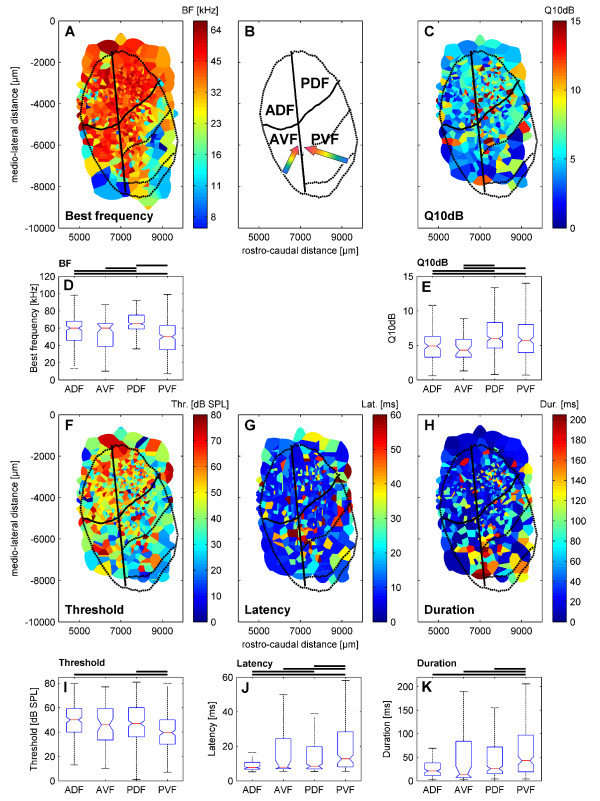
Spatial representation of response properties on the flattened cortical surface and statistical comparison between the four cortical fields. Tessellation maps of the spatial representation are shown for: A) Best frequency, C) Q10dB value, F) Response threshold, G) First spike latency and H) Response duration. The outlines of AC and AC subfields are superimposed (black lines as in Fig 1). Panel B) shows the topographic position of the AC subfields of P. discolor derived from neuroarchitectural characteristics. The arrows indicate BF gradients in the tonotopically organized ventral fields. Statistical analysis of different cortical subfields are shown for: D) Best frequency, E) Q10dB value, I) Response threshold, J) First spike latency and K) Response duration. Box plots show the median (red line) and the 25th and 75th percentiles. The 'whiskers' indicate the limits of the remaining percentiles. Outliers (Values >1.5 times the interquartile range) are not shown in the figure. The thick black lines above the plots indicate significant differences (Kruskal-Wallis test, p < 0.05). Abbreviations as in Fig. 1C.